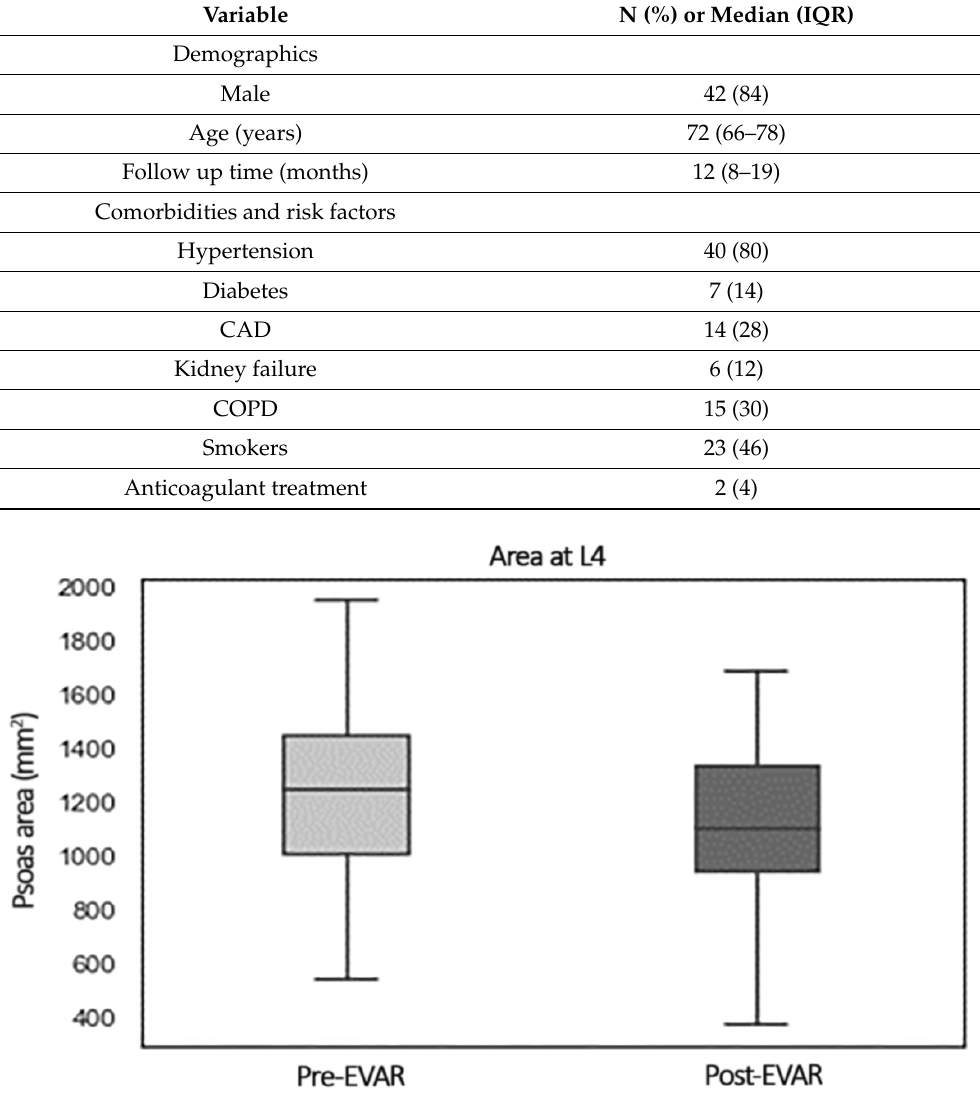
Table 1. Demographics and clinical data.